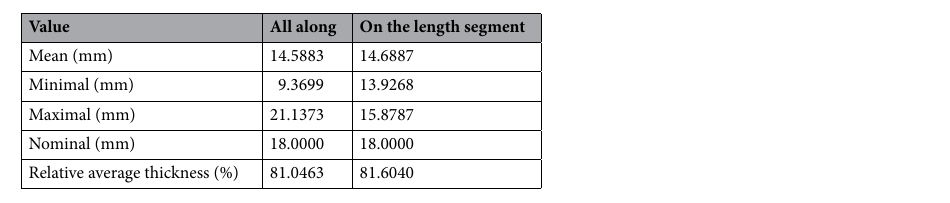
Table 3. Parameters for a three-dimensional image—device prototype